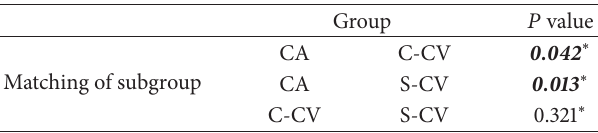
Table 3: Time interval differences from cataract surgery to Nd:YAG capsulotomy within